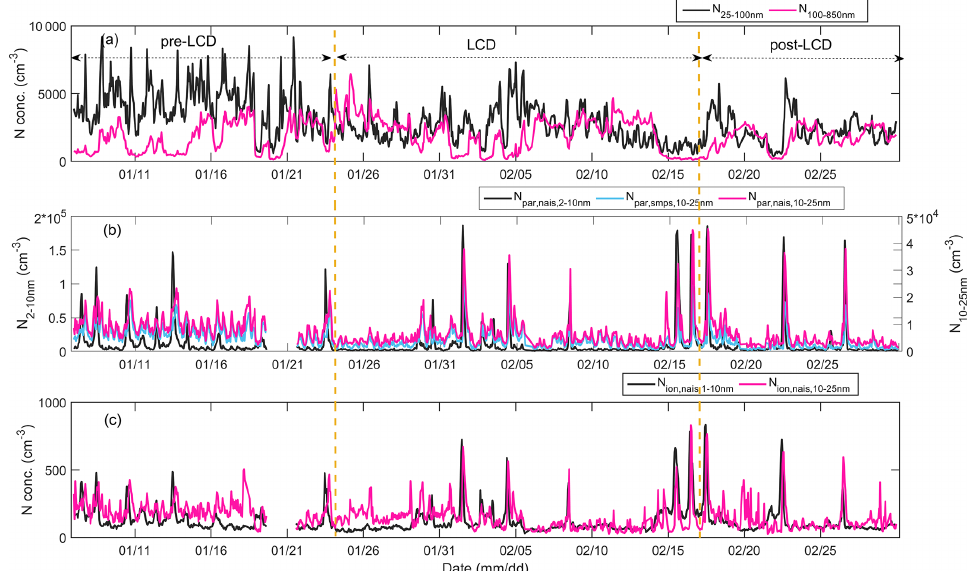
Figure 3. Time series of hourly mean of the number concentrations for different size ranges, including 25–100 and 100–850nm from SMPS data (a) , 2–10nm particles from NAIS and 10–25nm particles from both NAIS and SMPS (b) , and 1–10nm and 10–25nm positive ions from NAIS (c)